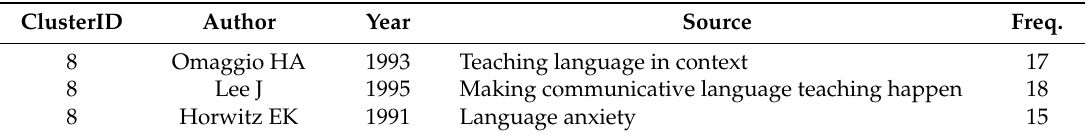
Table 10. The Members of Cluster